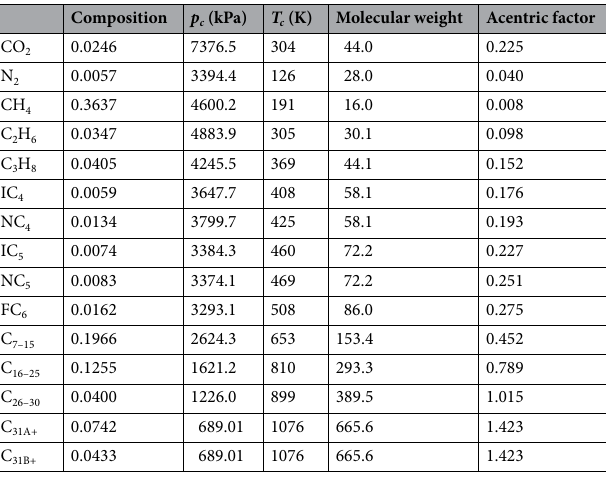
Table 1. Burke Oil 1 composition and